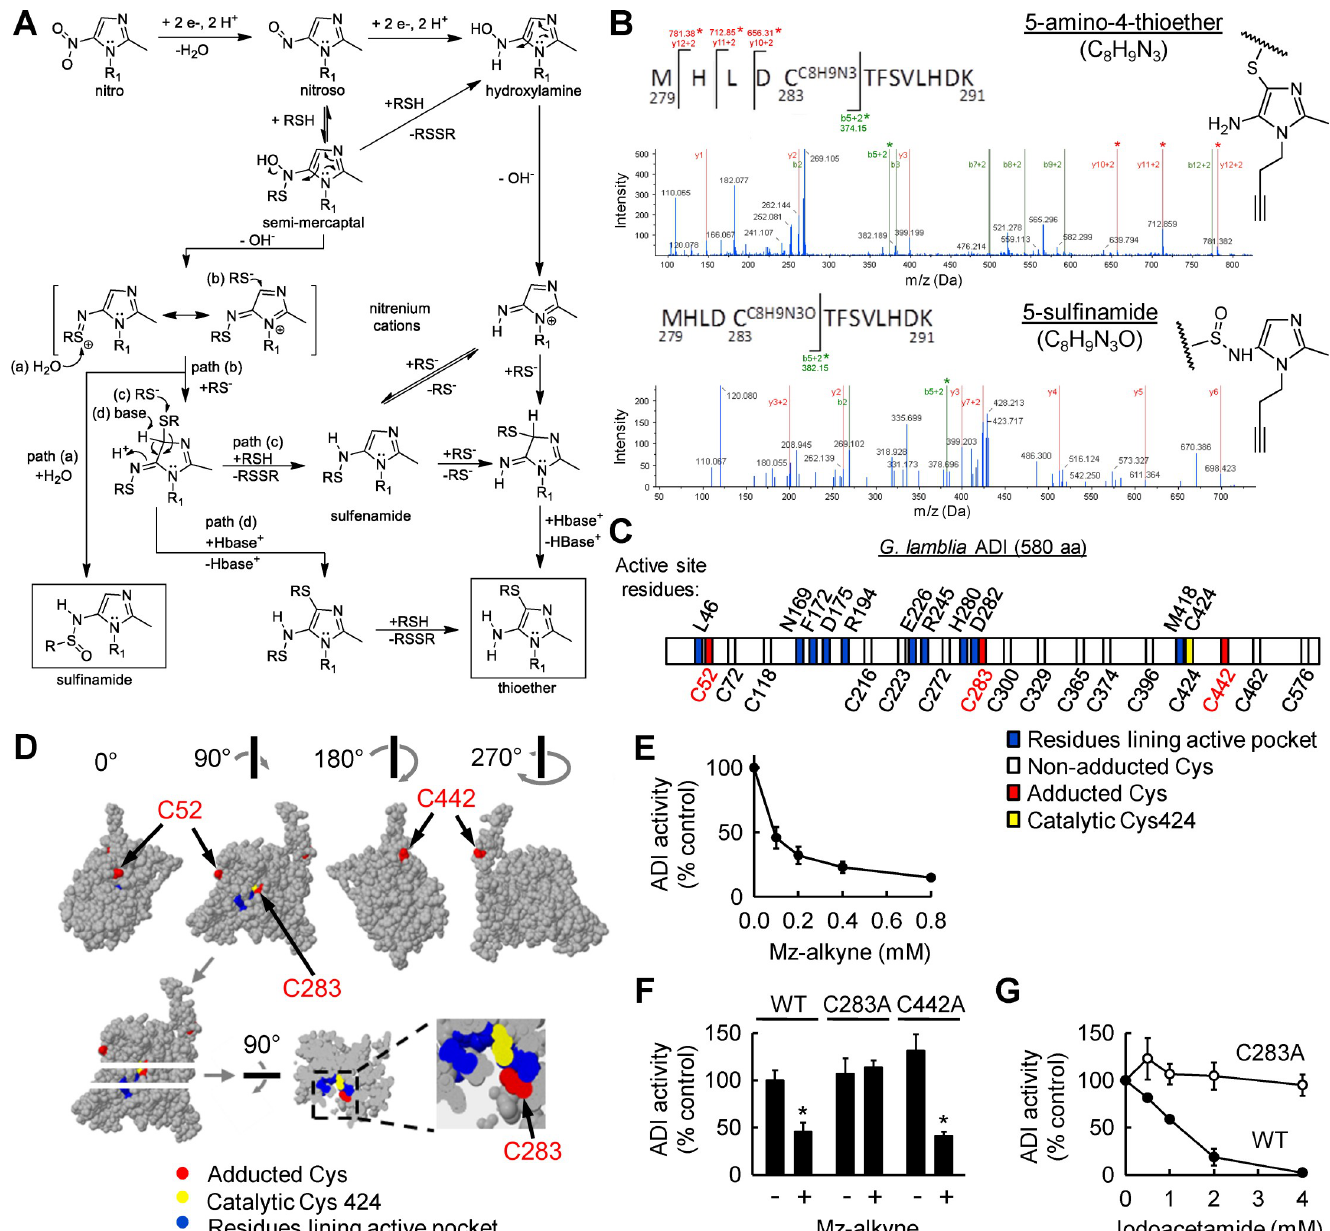
Fig 5. Functional impact of 5-NI adduction of ADI. (A) Proposed reaction mechanisms and structures of Mz-alkyne adducts on protein targets. (B) Example MS/ MS spectra of the ADI peptide, 279-MHLDCTFSVLHDK-291, obtained by tryptic digestion of Mz-alkyne adducted ADI-HA. On cysteine 283, three y+2 ions and one b+2 ion with an added mass of 147 were observed that constitute evidence for 5-amino-4-thioether (C8H9N3) adduction, and one b+2 ion with an added mass of 163 that provides evidence for 5-sulfinamide (C8H9N3O) adduction. The predicted structures of these cysteine adducts are shown on the right. (C) Scheme of G . lamblia ADI with known active site residues labeled above and cysteines labeled below. (D) Homology model of ADI protein structure and adduction sites. Residues lining the active site pocket are shown in blue, the catalytic cysteine 424 in yellow, and adducted cysteines in red. Images on top show the whole protein from different angles. One of the images was optically sectioned (dashed arrows) and rotated 90˚ around the indicated horizontal axis to reveal a top view of the section. The inset shows a magnification of the active site pocket. The adducted cysteine 283 is located at the entrance to the pocket. (E) ADI activity in lysates of G . lamblia trophozoites treated with the indicated concentrations of Mz-alkyne (mean ± SD, n = 3 experiments). (F) Activity of recombinant ADI produced as wild-type (WT) or with mutations of cysteine 283 to alanine (C283A) or cysteine 442 to alanine (C442A) after 2 h treatment with (+) or without (-) Mz-alkyne under cell-free conditions in the presence of dithionite. (G) Activity of WT and mutant (C283A) ADI after 2 h treatment with iodoacetamide. Activities in G and H are expressed relative to solvent controls (mean +/- SD, n = 3; � p < 0.05 vs controls).